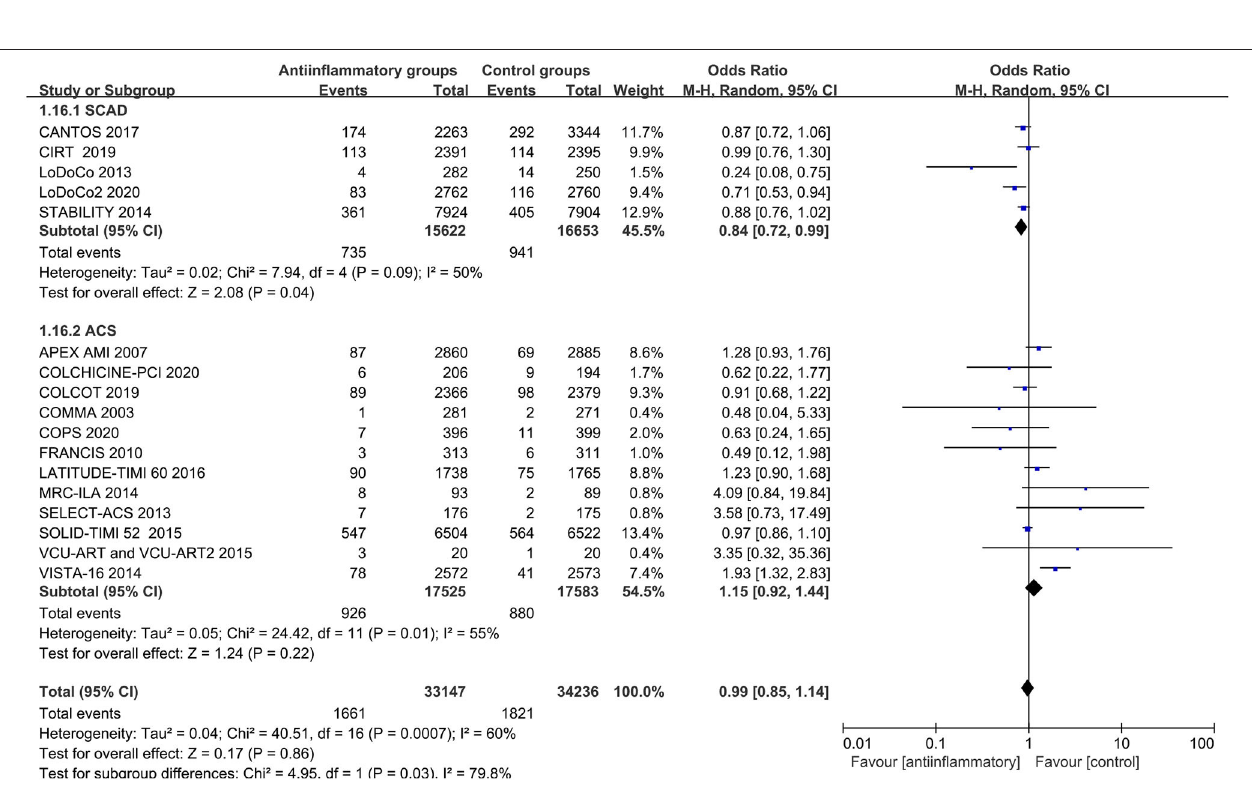
FIGURE 4 | Forest plots of studies evaluating recurrent myocardial infarction in patients with stable CHD vs. ACS.